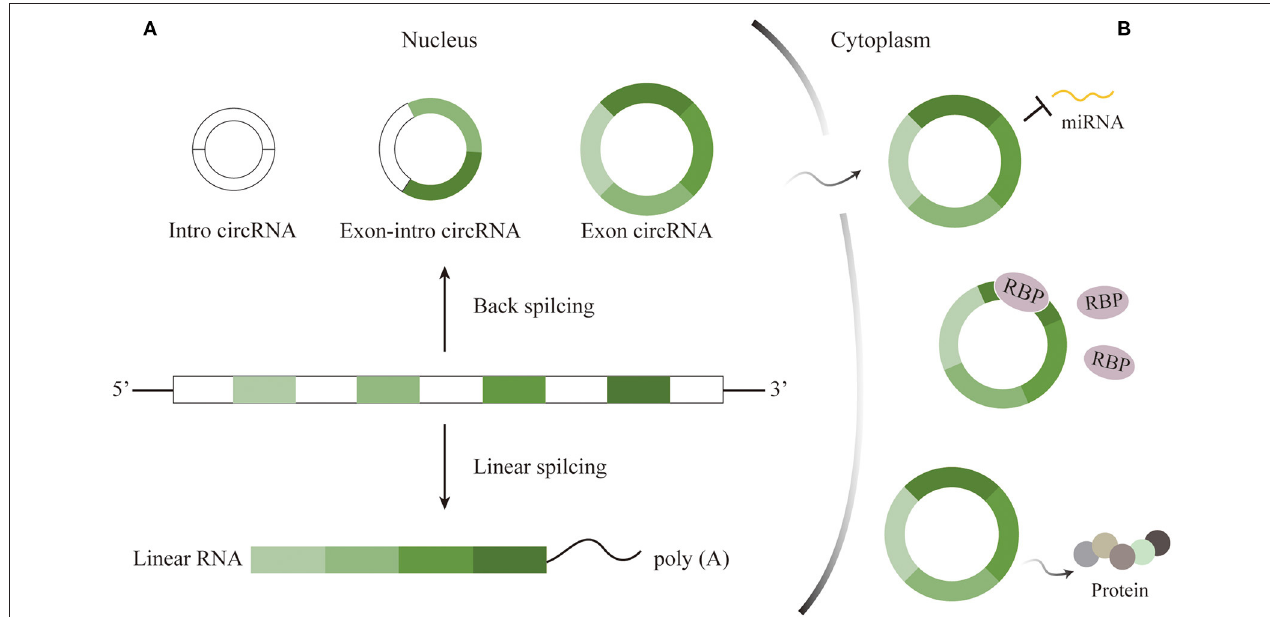
FIGURE 1 | Characteristics and functions of circRNAs. (A) Characteristics of circRNAs. circRNAs generated through back splicing can be divided into intron circRNAs, exon-intron circRNAs, and exon circRNAs. The first two kinds remain in nucleus, while exon circRNAs then localize to cytoplasm to play roles. (B) Functions of circRNAs. CircRNAs could serve as miRNA sponges, interact with RBP, and translate functional proteins to take part in important biological